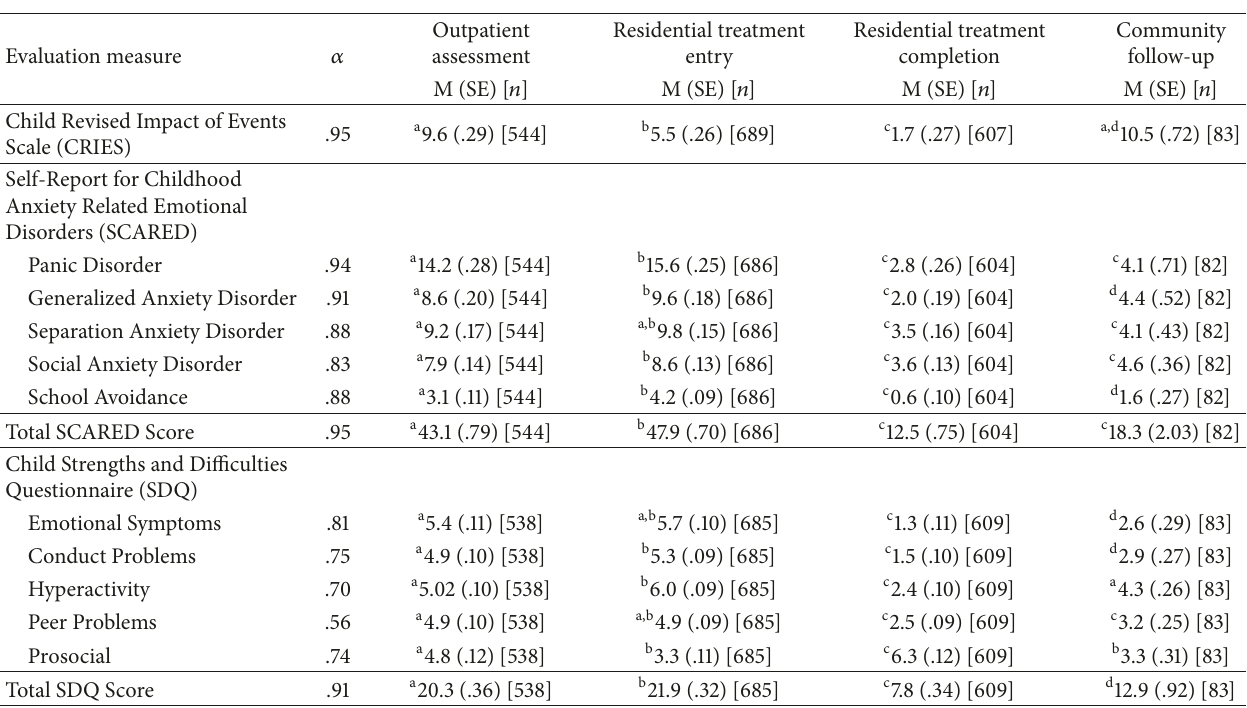
Table 2: Internal consistency reliability at residential treatment entry, estimated marginal means (M), Standard Errors (SE), and sample sizes [𝑛] at outpatient assessment, residential treatment entry, residential treatment completion, and community follow-up for the younger child sample ( 𝑁 = 689